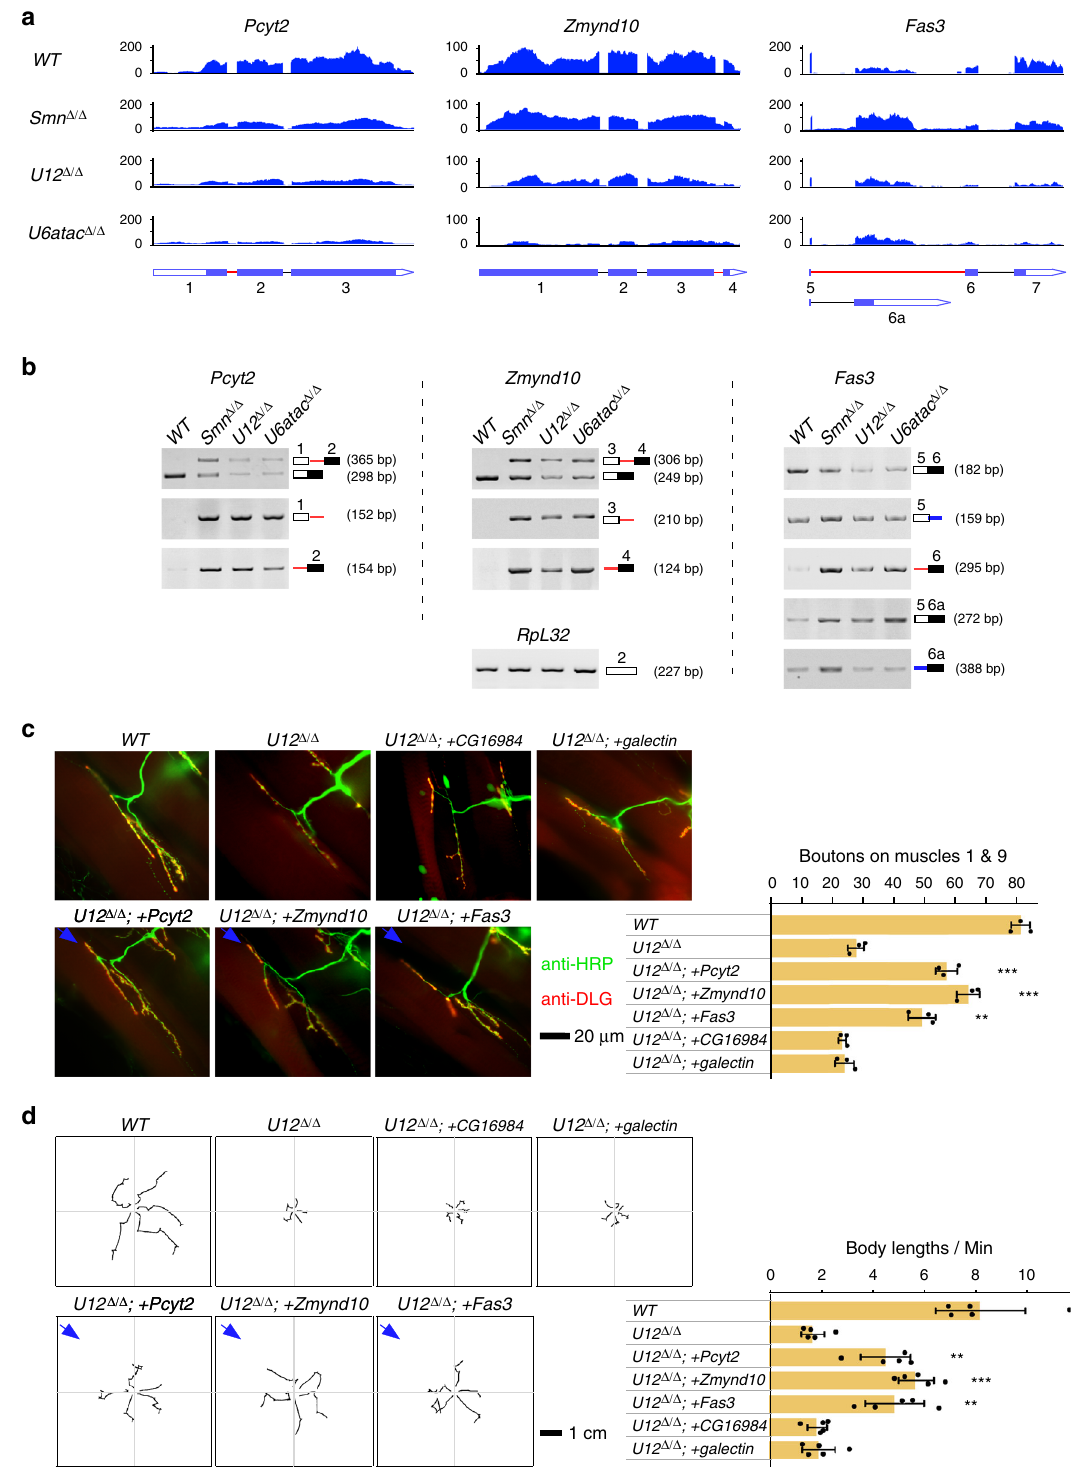
Fig. 4 Pcyt2 , Zmynd10 , and Fas3 are targets of the minor spliceosome. a RNA-seq signals of the three genes in the four Drosophila strains. minS-Is are indicated. b Splicing of minS-Is of the three genes are signi fi cantly inhibited in deletion strains. Multiple sets of primers for each intron are used for RT-PCR. Red lines: minS-Is; black lines: U2-type introns; blue lines: mixture of the minor and major spliceosomes recognized introns. c Decreased NMJ boutons are rescued by neural expression of the three genes in U12 Δ / Δ background ( U12 Δ / Δ ; + Pcyt2 : p = 0.00059; U12 Δ / Δ ; + Zmynd10 : p = 0.00028; U12 Δ / Δ ; + Fas3 : p = 0.00428). d Impaired larval locomotion caused by U12 Δ / Δ are improved by neural expression of the three genes ( U12 Δ / Δ ; + Pcyt2 : p = 0.0023; U12 Δ / Δ ; + Zmynd10 : p = 2.9e − 5; U12 Δ / Δ ; + Fas3 : p = 0.00324). Data represent the mean ± SD from fi ve representatives of each strain. ** p < 0.01, *** p < 0.001. p values were calculated using two-sided t -test. Source data are provided as a Source Data fi